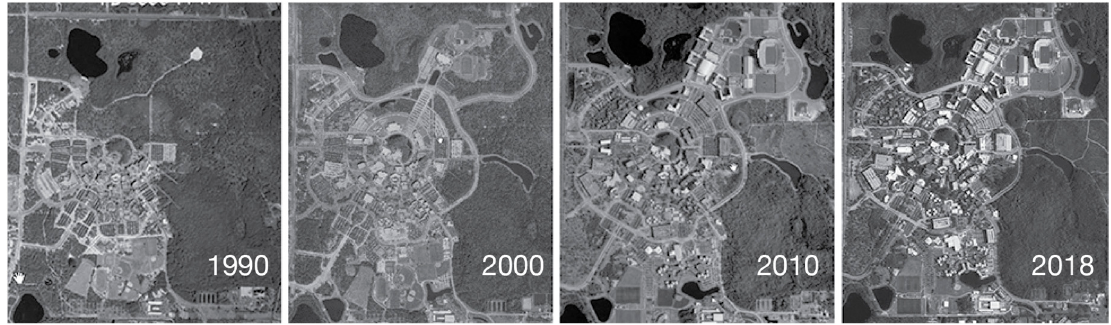
Figure 1. Satellite images of the University of Central Florida (UCF) campus.